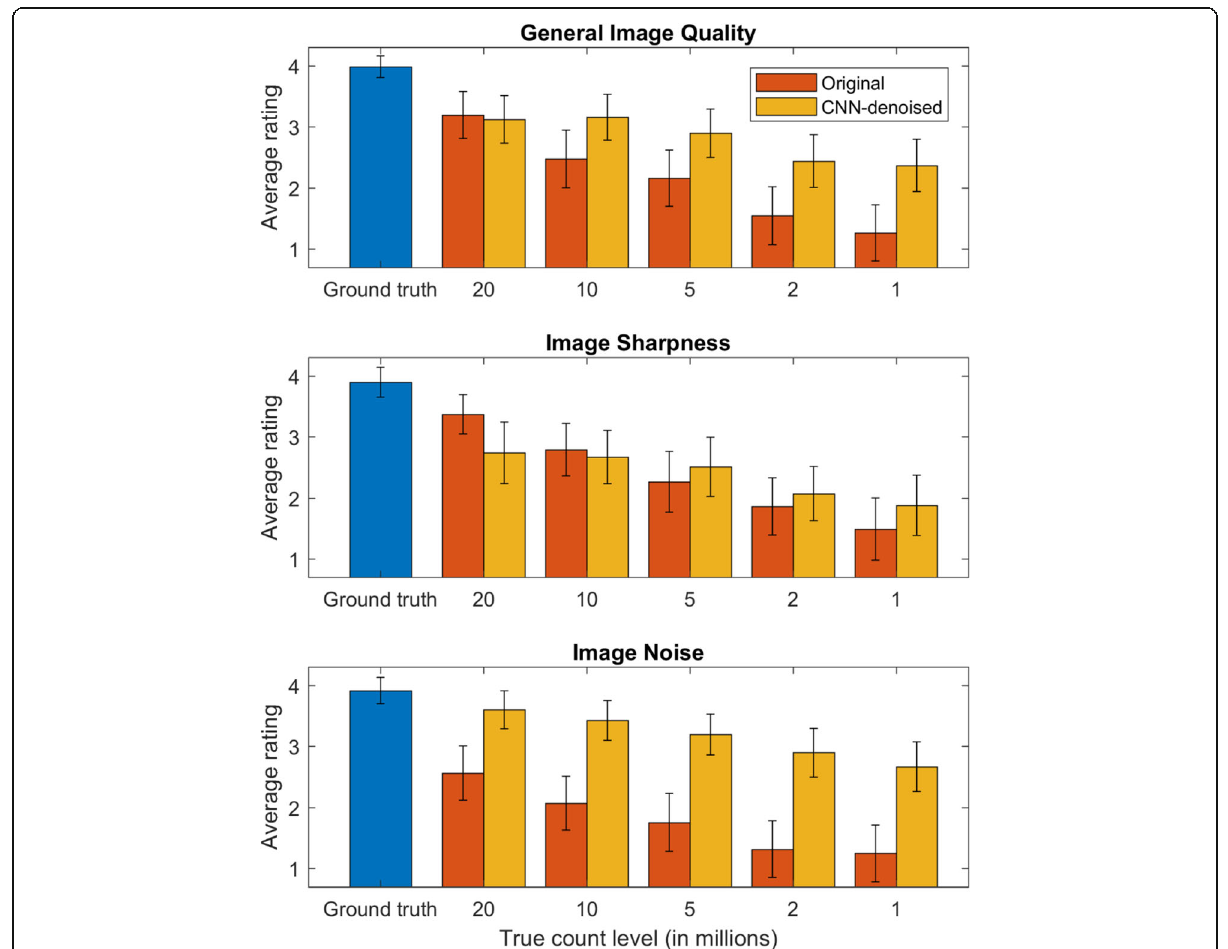
Fig. 5 Image ratings determined by the 3 physicians in the reading task, pooled and averaged for each count level (higher is better). The standard deviation across all readers and images are indicated by the error